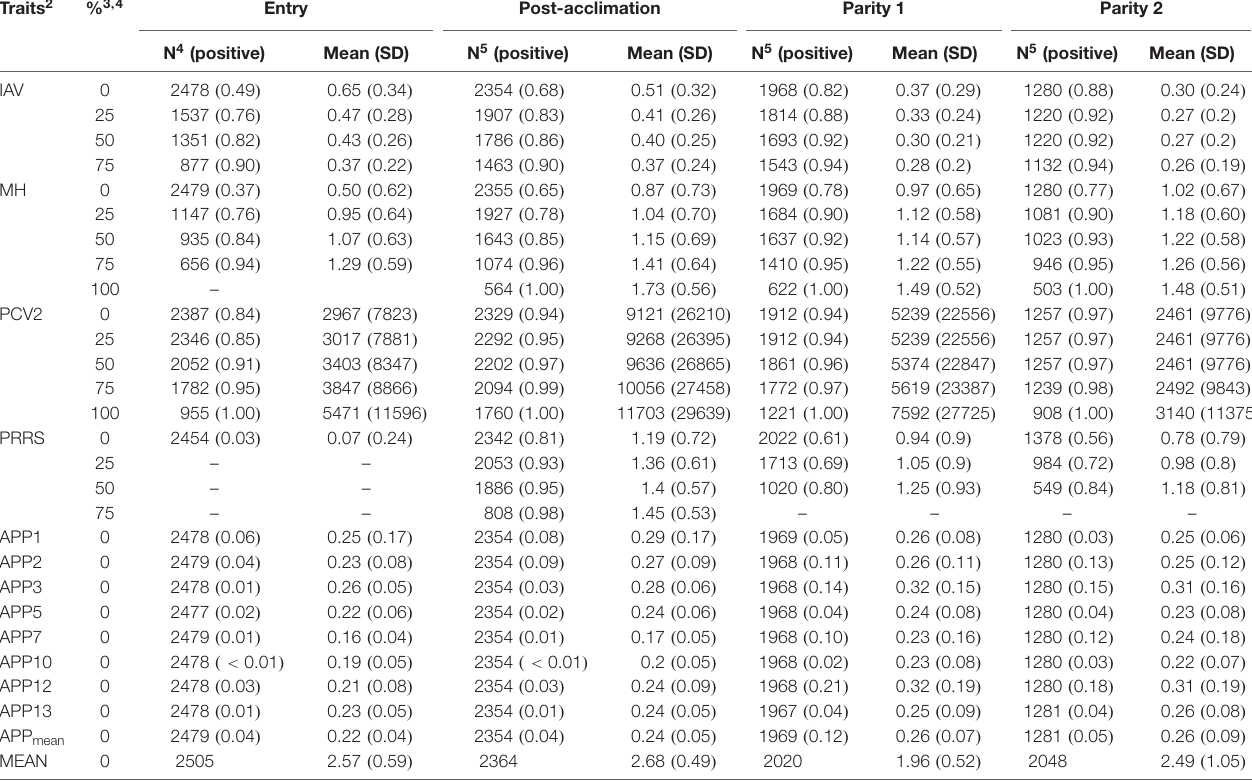
TABLE 2 | Number of individuals and mean of antibody response across pathogens 1 , time points, and seropositive (%) datasets. Traits